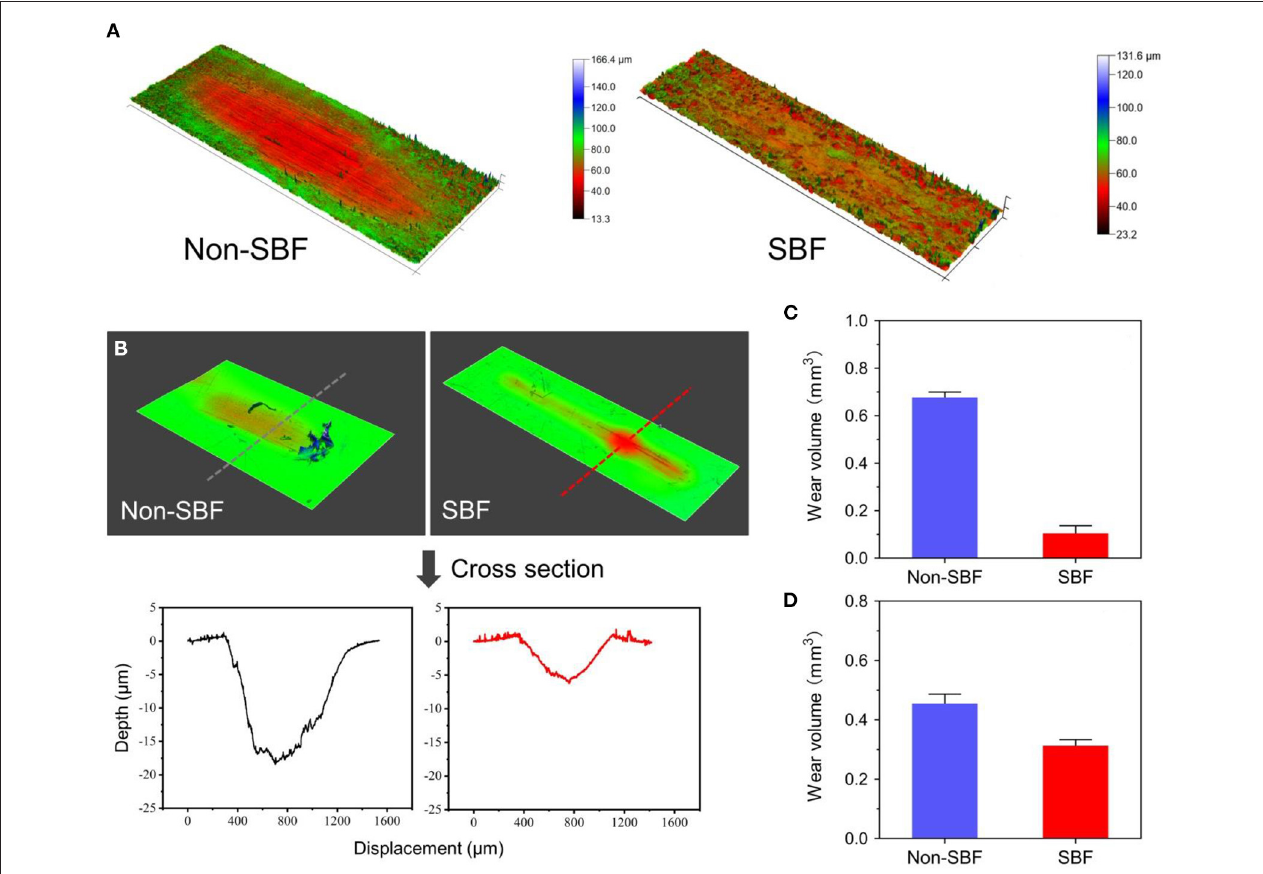
FIGURE 11 | Surface wear morphology observation and wear volume. (A) Surface wear morphology observation of cervical vertebra fixation (CVF) link junction; the color represents the degree of wear. (B) The wear morphology cross-section of cervical disc prosthesis (CDP) link junction. Total wear volume of the (C) CVF link junction and the (D) CDP link junction was